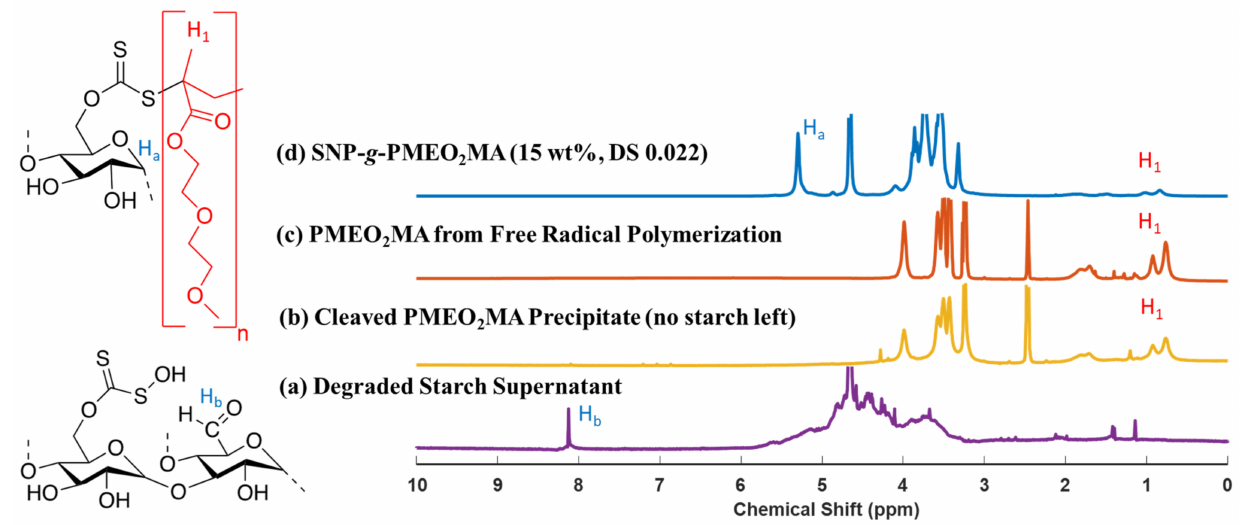
Figure 2. 1 H NMR spectra for ( a ) oxidized and degraded starch supernatant at 25 ◦ C, ( b ) cleaved PMEO 2 MA precipitate, ( c ) PMEO 2 MA, ( d ) SNP- g -PMEO 2 MA (15%, DS 0.022). The labels in the spectra identify the different types of protons in the structures on the left.